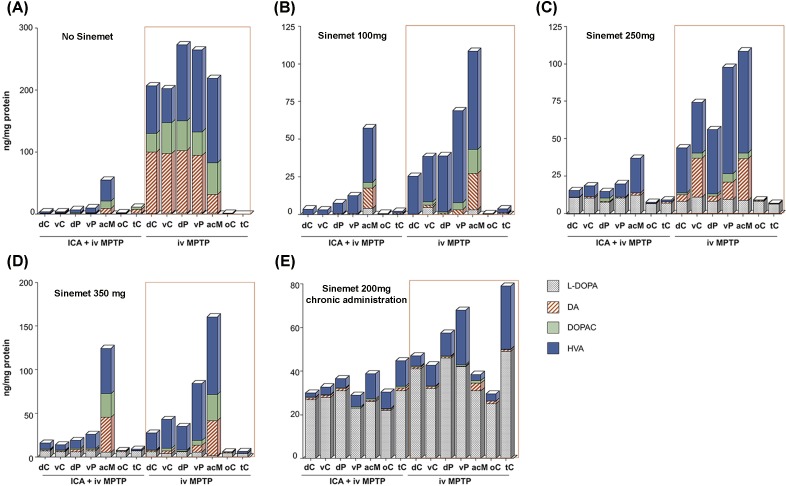
Dopamine metabolism after L-DOPA treatment in overlesioned MPTP monkeys.Dopamine and its metabolites were evaluated in different regions of the striatum of asymmetrically parkinsonian NHP that had been administered different doses of Sinemet 45 min prior to necropsy. Each graph shows data obtained from an individual animal receiving a different Sinemet dose. HPLC analysis of the different brain regions revealed that the severely lesioned side (ICA + iv MPTP) was almost completely devoid of DA and its metabolites compared to the partially lesioned side (iv MPTP), in which reduction was also milder in most of the regions analyzed (A). Analysis of the same regions in MPTP animals euthanized 45 min after the last dose of Sinemet indicated a similarly reduced conversion of L-DOPA into DA to that seen in the control animal (A), regardless of the dose of Sinemet received [(B) Sinemet 100 mg, (C) Sinemet 250 mg or (D) Sinemet 350 mg]. Another animal was chronically treated for 2 months with 200 mg Sinemet daily and euthanized 45 min after the last Sinemet dose (E). This animal had higher L-DOPA levels on both sides, whereas DA levels remained as low as those in the acutely challenged animals. Abbreviations: acM: nucleus accumbens; dC: dorsal caudate nucleus dP: dorsal putamen; ICA: intracarotid artery; iv: intravenous; vC: ventral caudate nucleus; vP: ventral putamen; oC: temporal cortex; tC: temporal cortex.